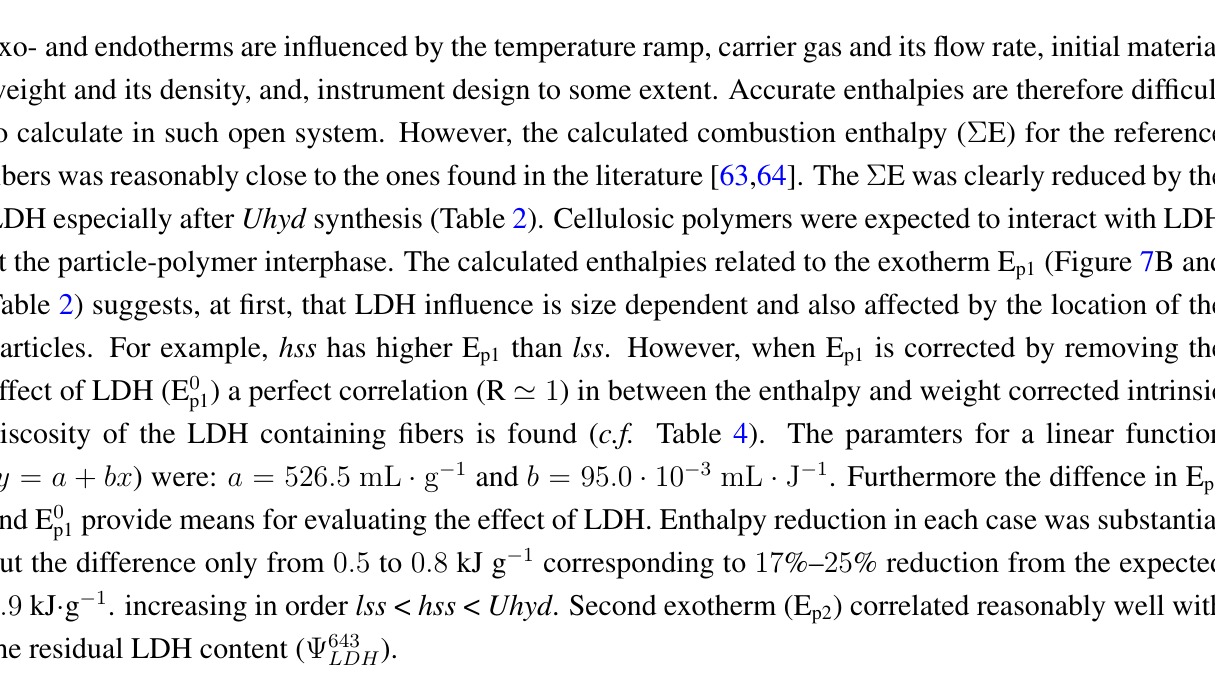
H was acquired from Stølen and fus m